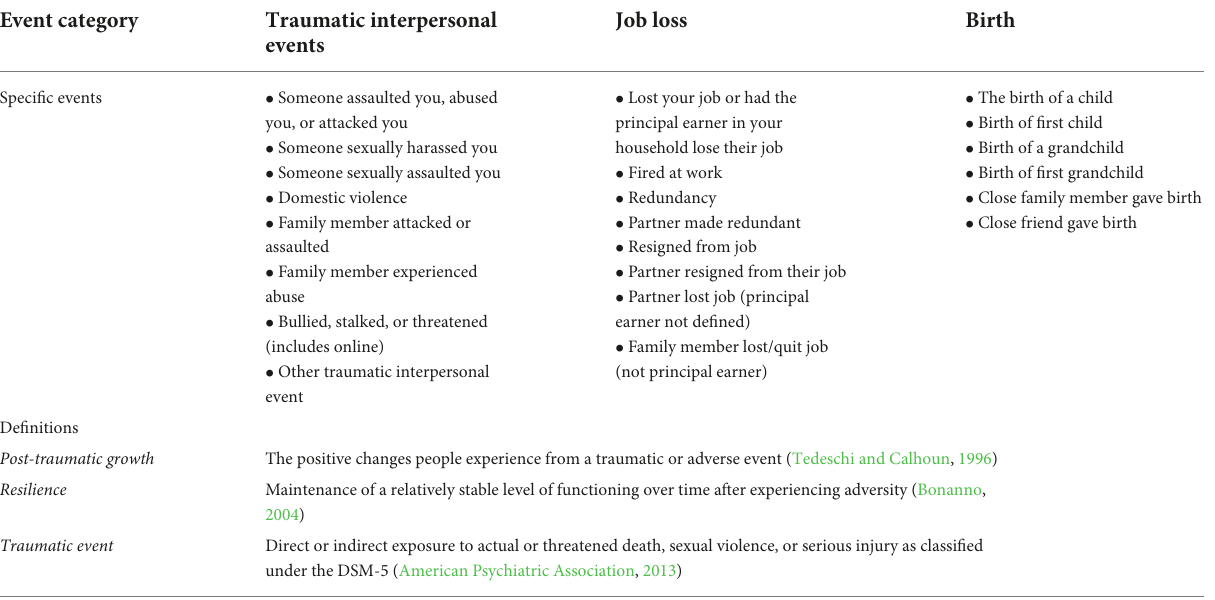
TABLE 1 Specific events included in the three event categories examined as measured using the BISLE and definitions of key constructs. Event